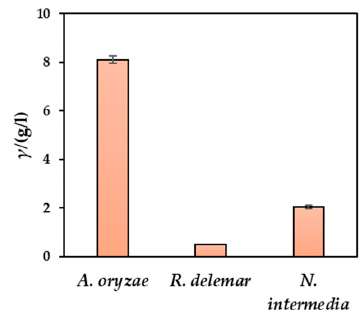
Figure 2. Comparison of the growth performance of A. oryzae , R. delemar , and N. intermedia considering the mass concentration of fungal biomass obtained after 96 h cultivation in undiluted olive oil mill wastewater (OMWW).